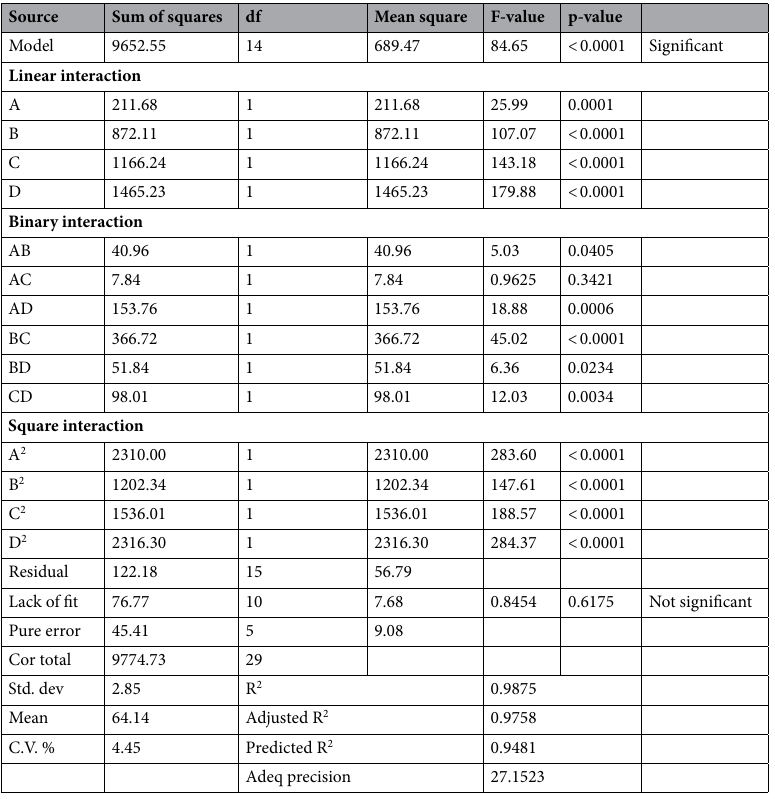
Table 2. Regression coefficients and ANOVA analysis of the quadratic model calculated with the stepwise